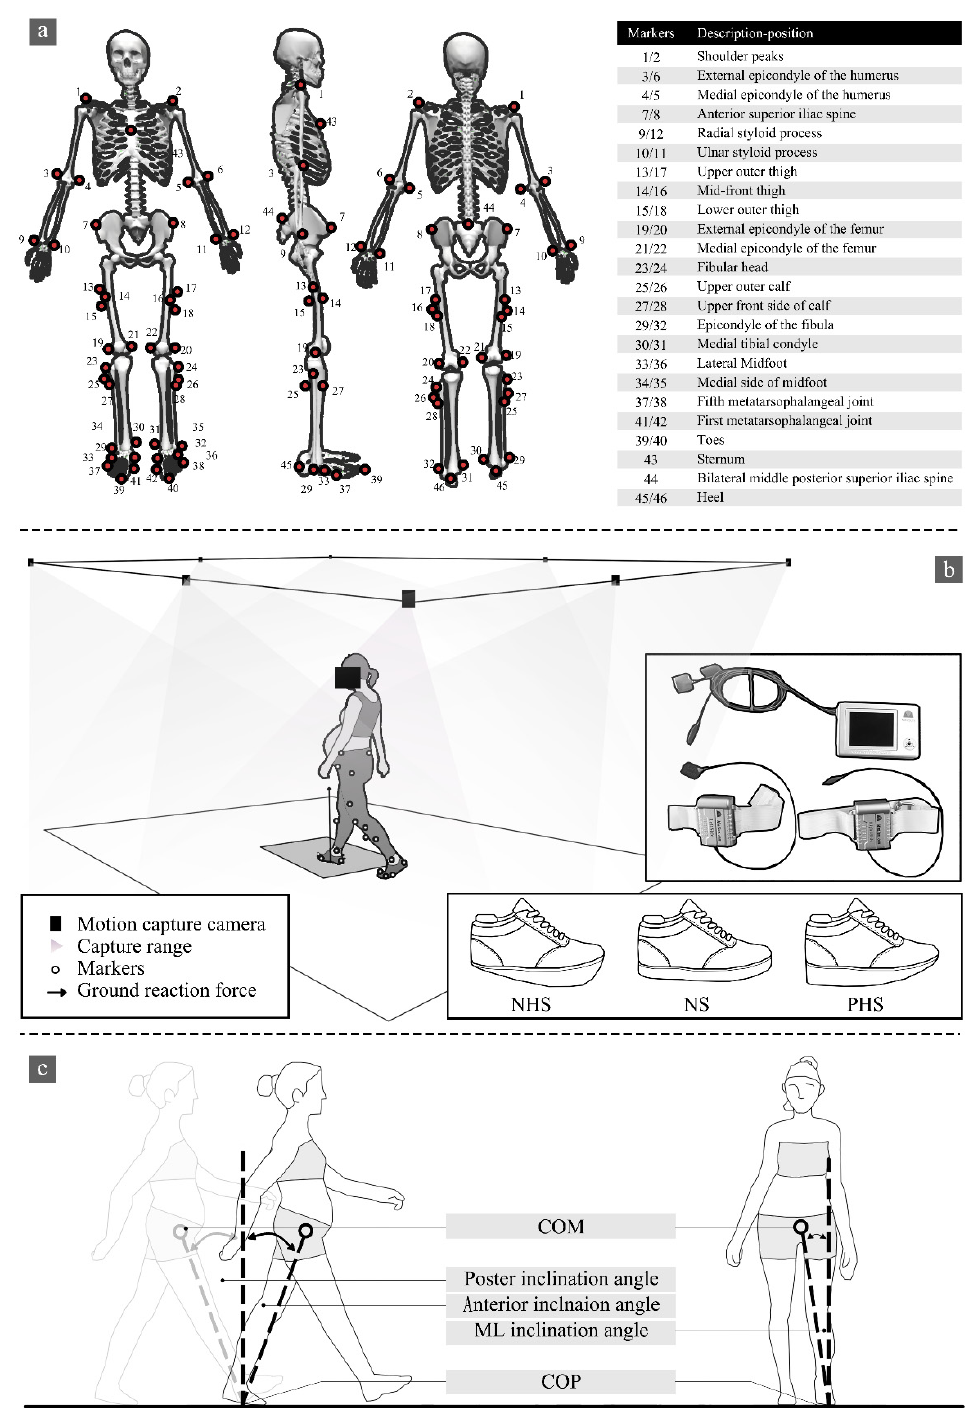
Figure 1. ( a ) Marking point paste location. ( b ) Experimental process, IDEEA position, and shoe con- ditions between NHS (negative 1.5 cm drop), NS (no drop), and PHS (1.5 cm drop). ( c ) Diagrammatic illustration of COM-COP inclination angles.